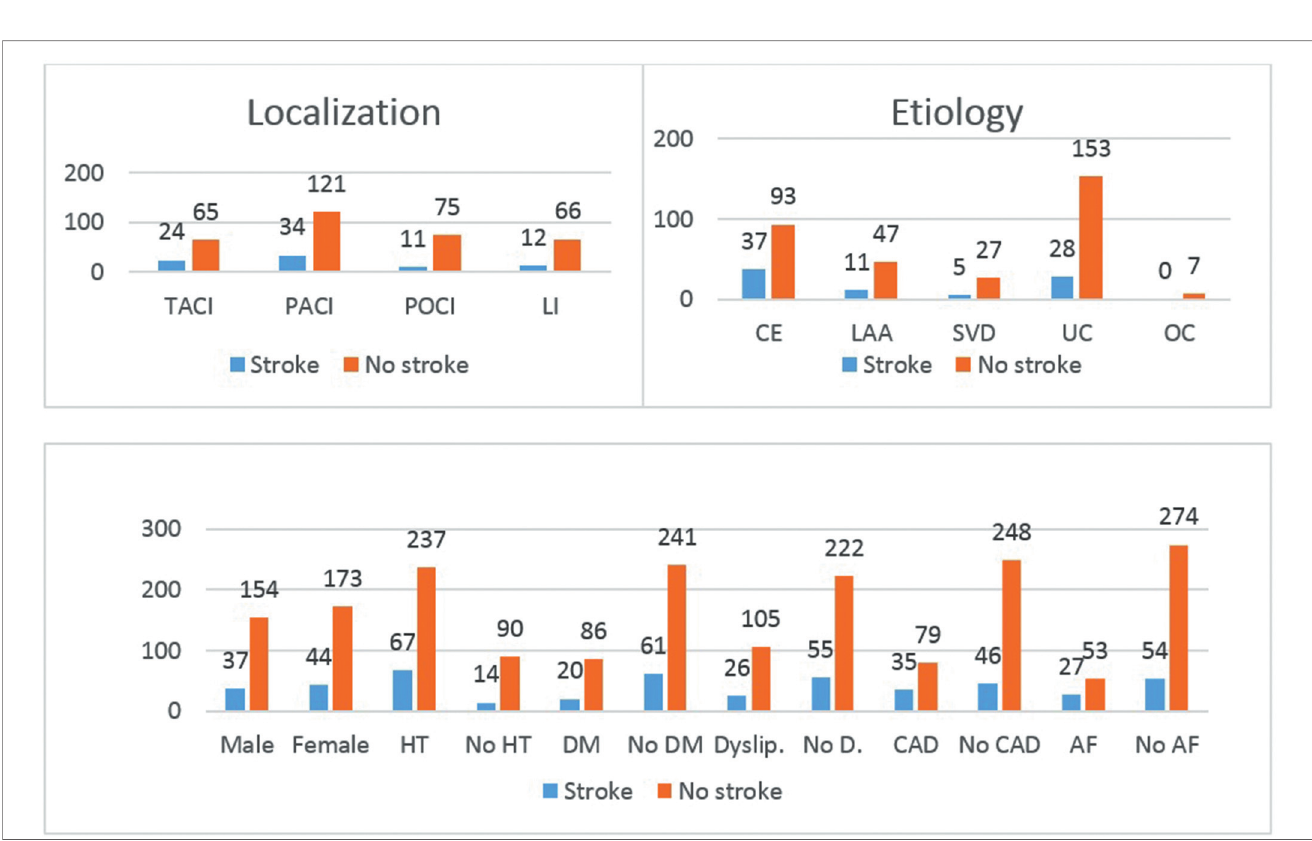
Figure 1. Relationship between localization, etiology, vascular risk factors, and previous stroke history in ischemic